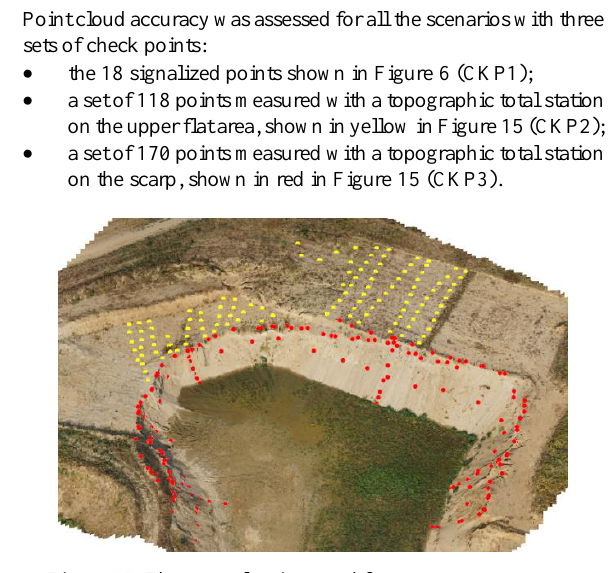
Figure 15. The control points used for accuracy assessment